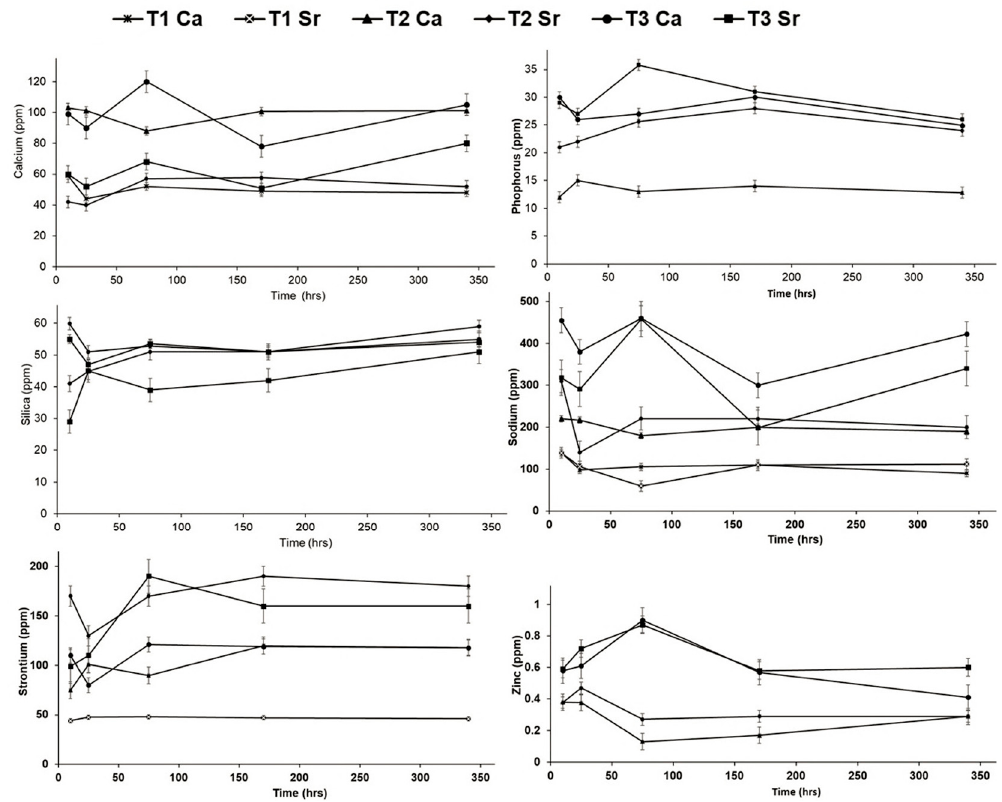
Figure 9. The release of ions from the bone scaffold after immersion in the Tris-buffer.